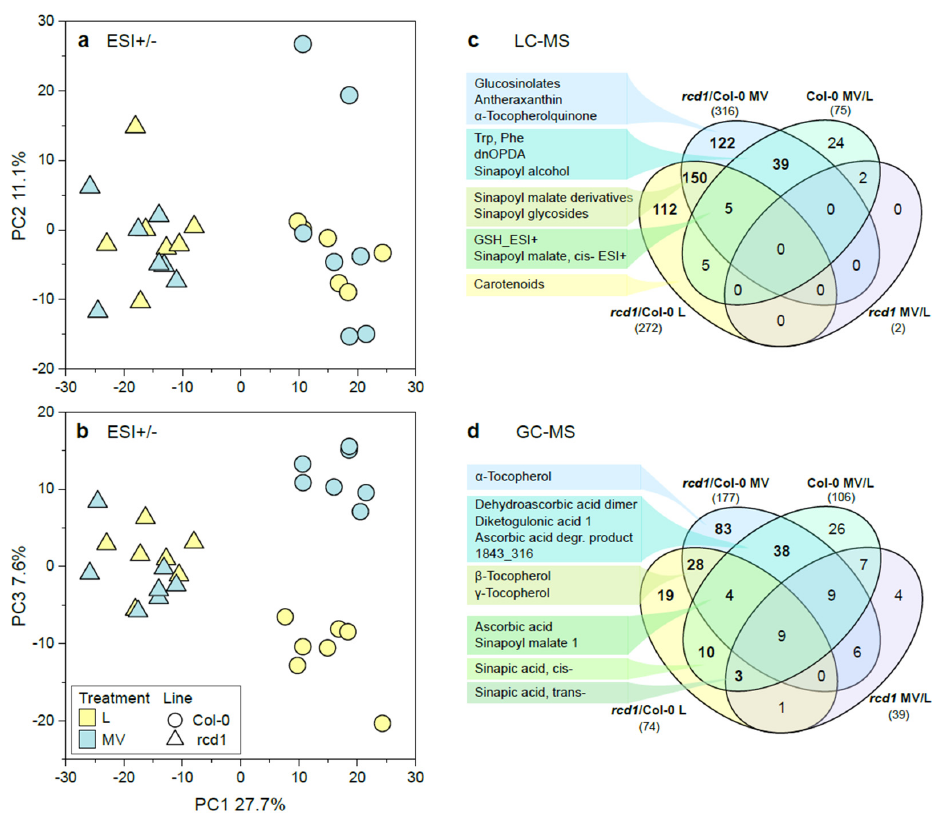
Figure 1. Metabolite profiles in Arabidopsis as affected by line and treatments. Metabolites were analyzed by LCMS with positive and negative ESI, and the variation in metabolite profiles (1146 features, n = 7) was studied with principal component analysis (PCA). ( a ) PC1 vs. PC2, ( b ) PC1 vs. PC3. In addition, the variation in lipophilic metabolite profile (16 metabolites analyzed with LCMS using positive ESI) was studied (Supplementary Figure S1d). Venn diagrams ( c , d ) depict the overlap of significantly affected metabolites between lines and different treatments. ( c ) Metabolites iden- tified by LC-MS, and ( d ) by GCMS [13] in selected sectors are shown. See the details of statistical results, additional PCA plots, and pairwise comparisons for metabolite levels in Supplementary